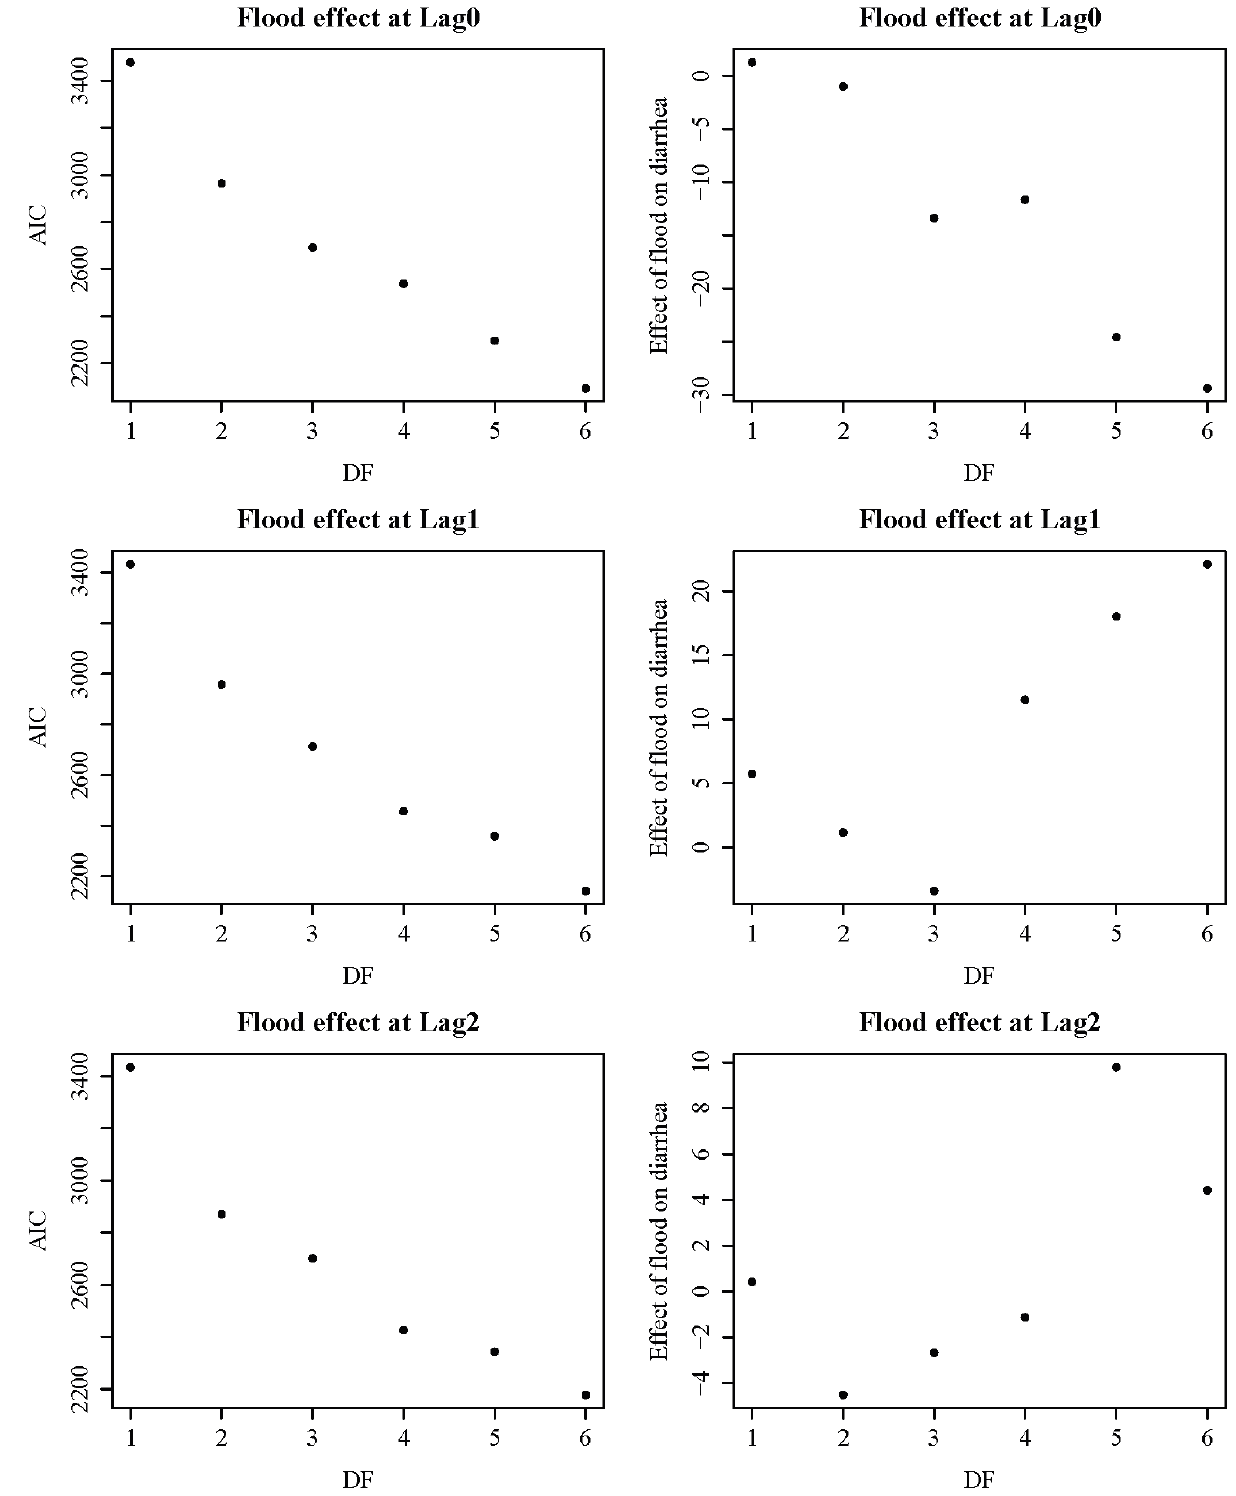
Figure A2. AIC and flood effect estimates on diarrhoea according to changing degree of freedom (DF) from one to six. We selected four degrees of freedom, showing smaller AIC and relatively stable effect estimate of flood on